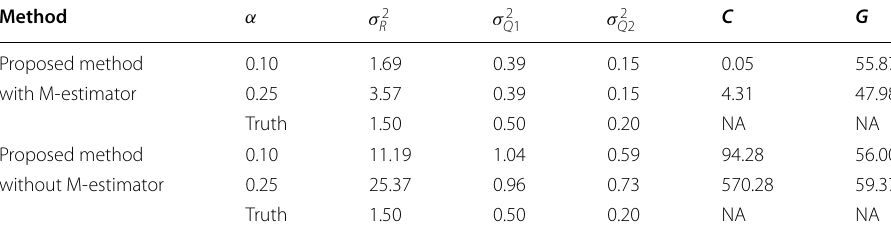
Table 4 Variance estimates and localization errors, linear model with outliers, n = 20